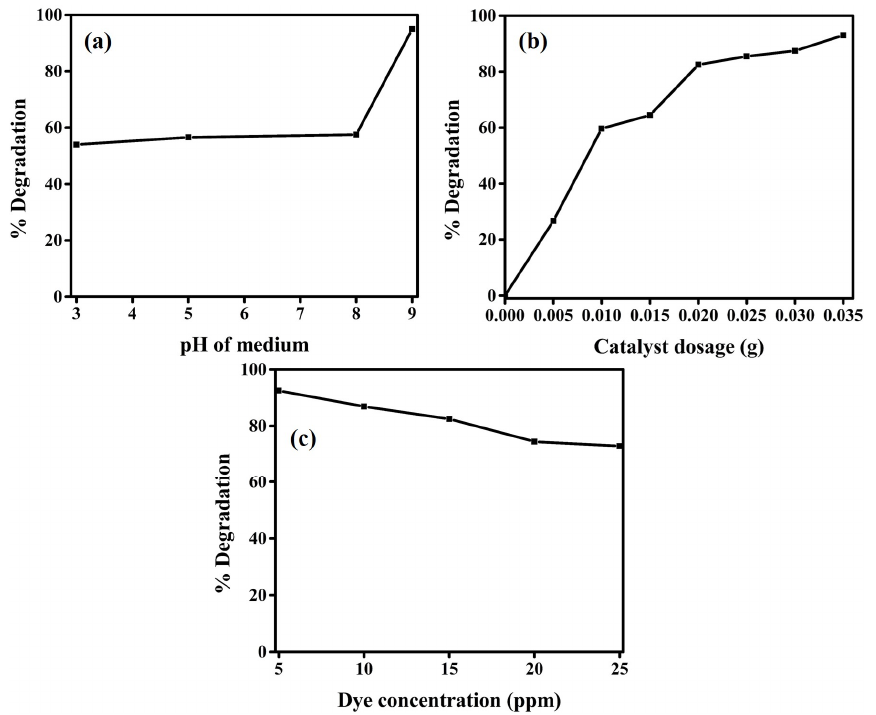
Figure 5. ( a ) Effect of pH of the medium on the MB PD ( b ) effect of calcined rust NPs dosage on the 346 MB PD ( c ) effect of the initial concentration of MB on the PD. 347 MB PD ( c ) effect of the initial concentration of MB on the